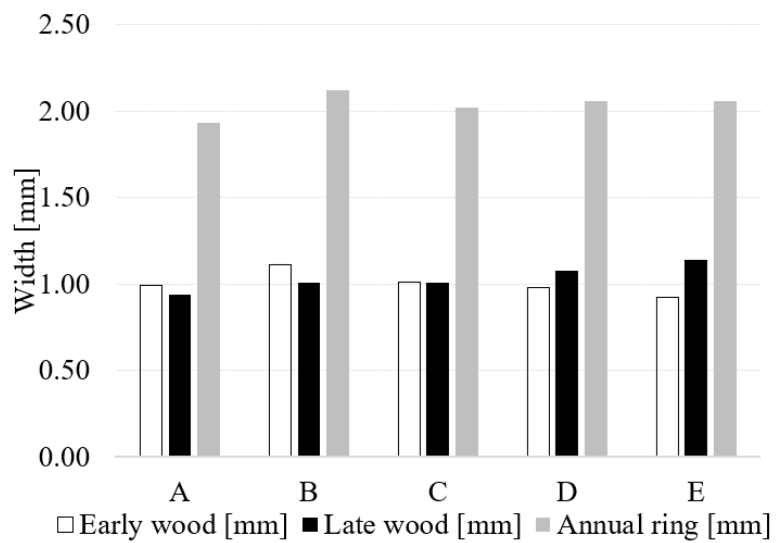
Figure 2. Mean widths of the annual ring of earlywood and latewood depending on the pruning variant (68 years after the procedure).